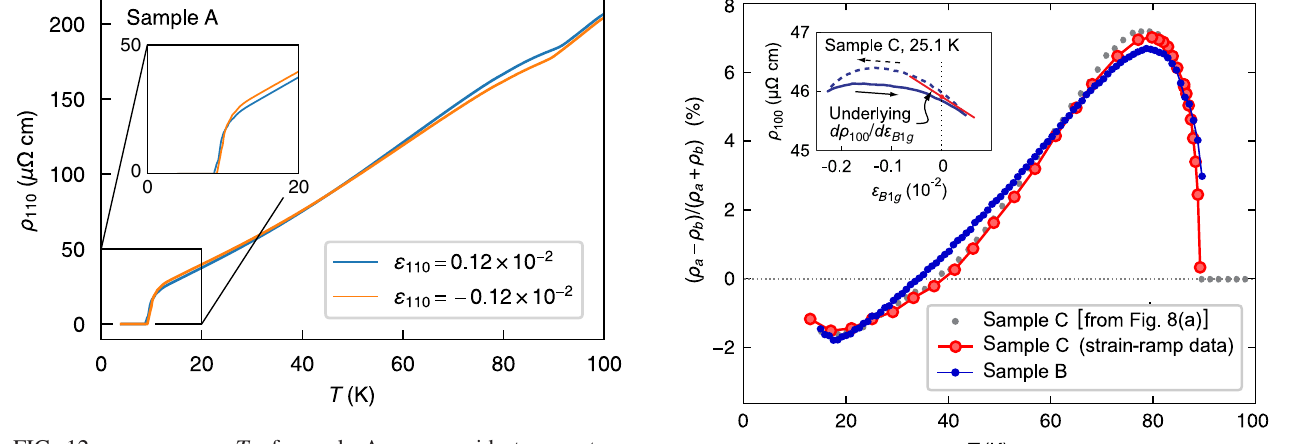
FIG. 13. Nematic resistivity anisotropy ð ρ sample C, derived from the strain-ramp data shown in Fig. 6(a). This determination is based on extraction of equilibrium slopes ¼ 0 , obtained by averaging the observed d ρ =d ε at ε B 1 g B 1 g increasing- ε and decreasing- ε slopes at ε the